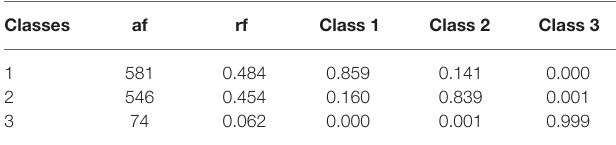
TABLE 4 | Frequency of students in the classes and accuracy of classification in each class of the best